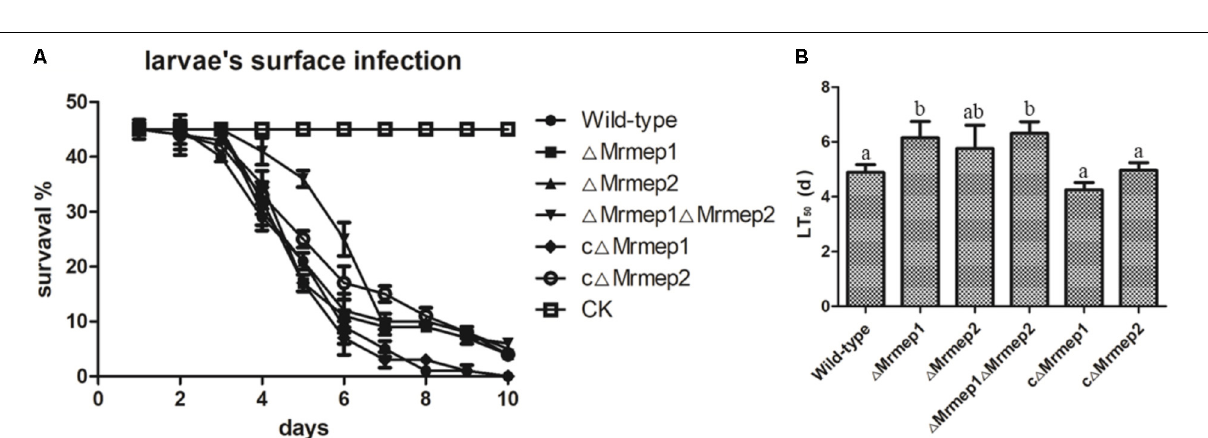
FIGURE 4 | The rate of growth inhibition (RGI%) of the mutants in cell wall-disrupting compounds. (A) Mutant strains were spot inoculated onto PDA plates with 0.025% SDS. (B) Mutant strains were spot inoculated onto PDA plates with 0.3 mg mL - 1 Congo red.